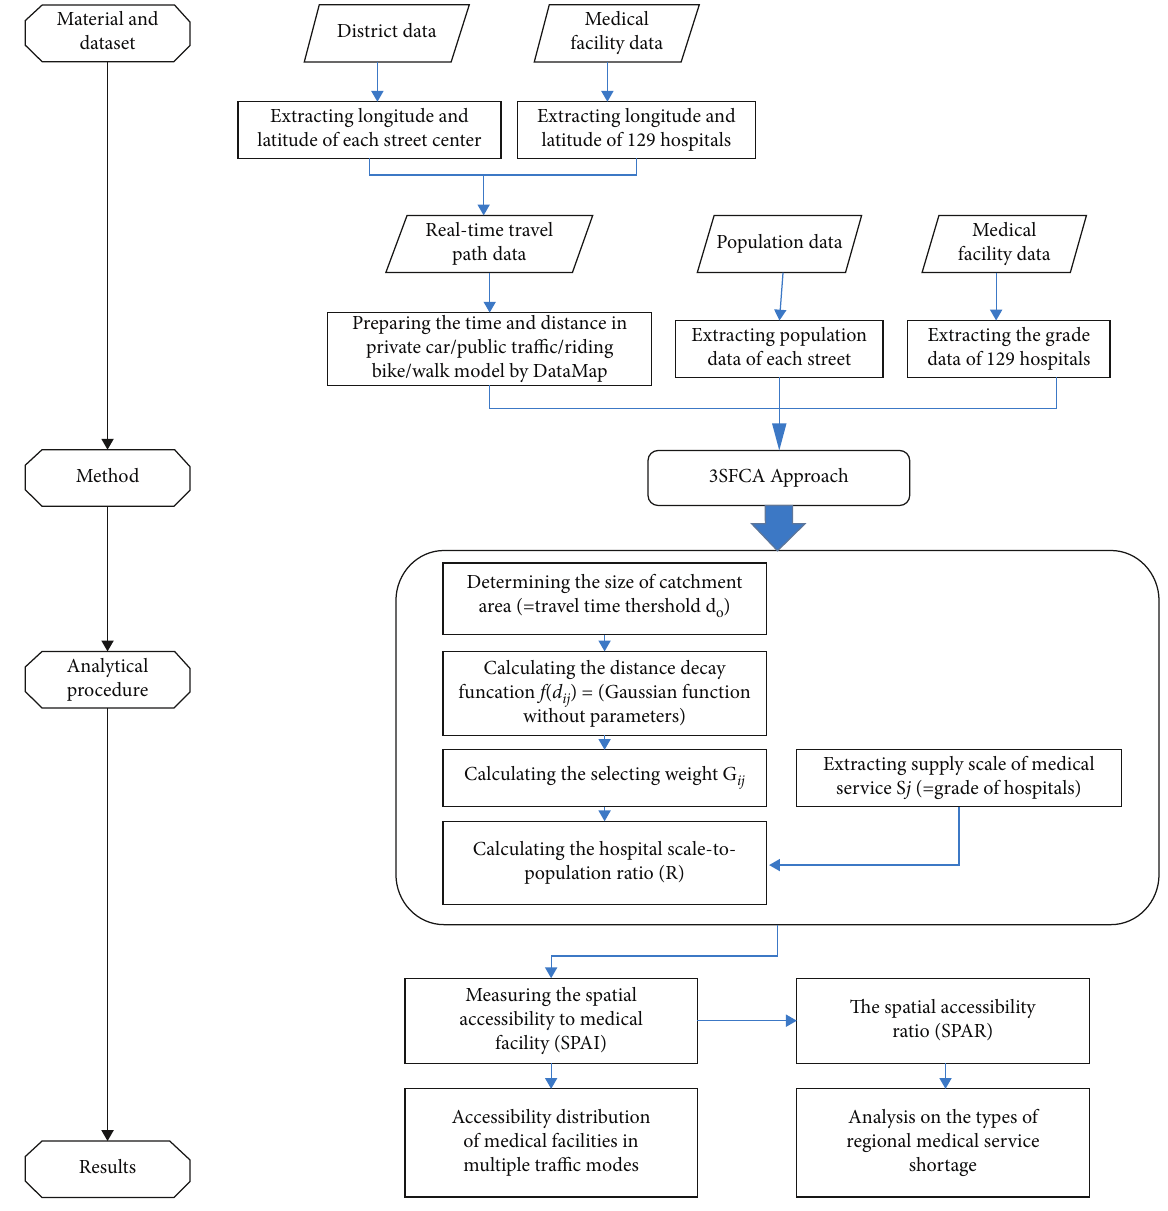
Figure 2: The research process of this study. Table 2: Traffic time thresholds to medical facilities in different traffic Modes (in